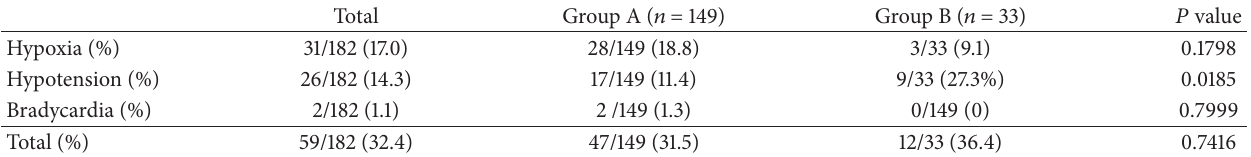
Table 4: Adverse events associated with cardiopulmonary functions in each group.